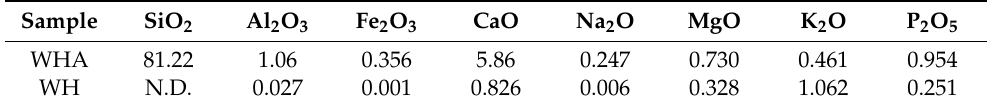
Table 2. Compositions of WH and WHA.